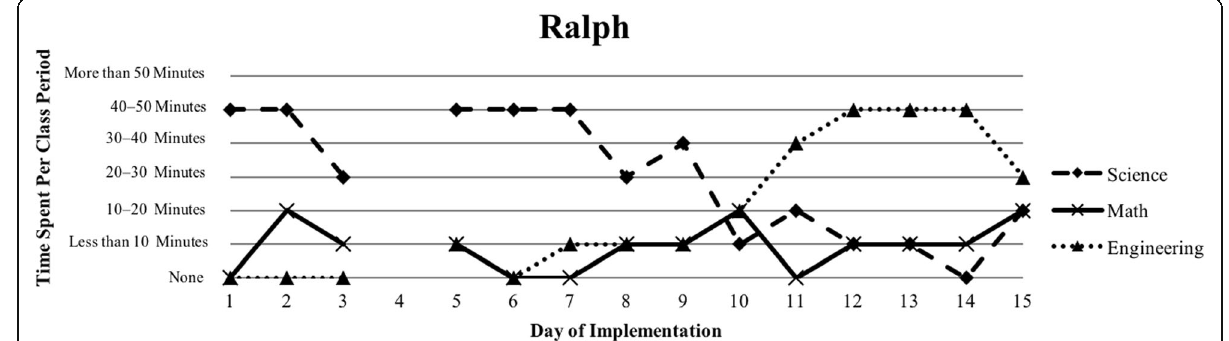
Fig. 9 Ralph ’ s implementation of the Heat Transfer 2 in his 6th grade science